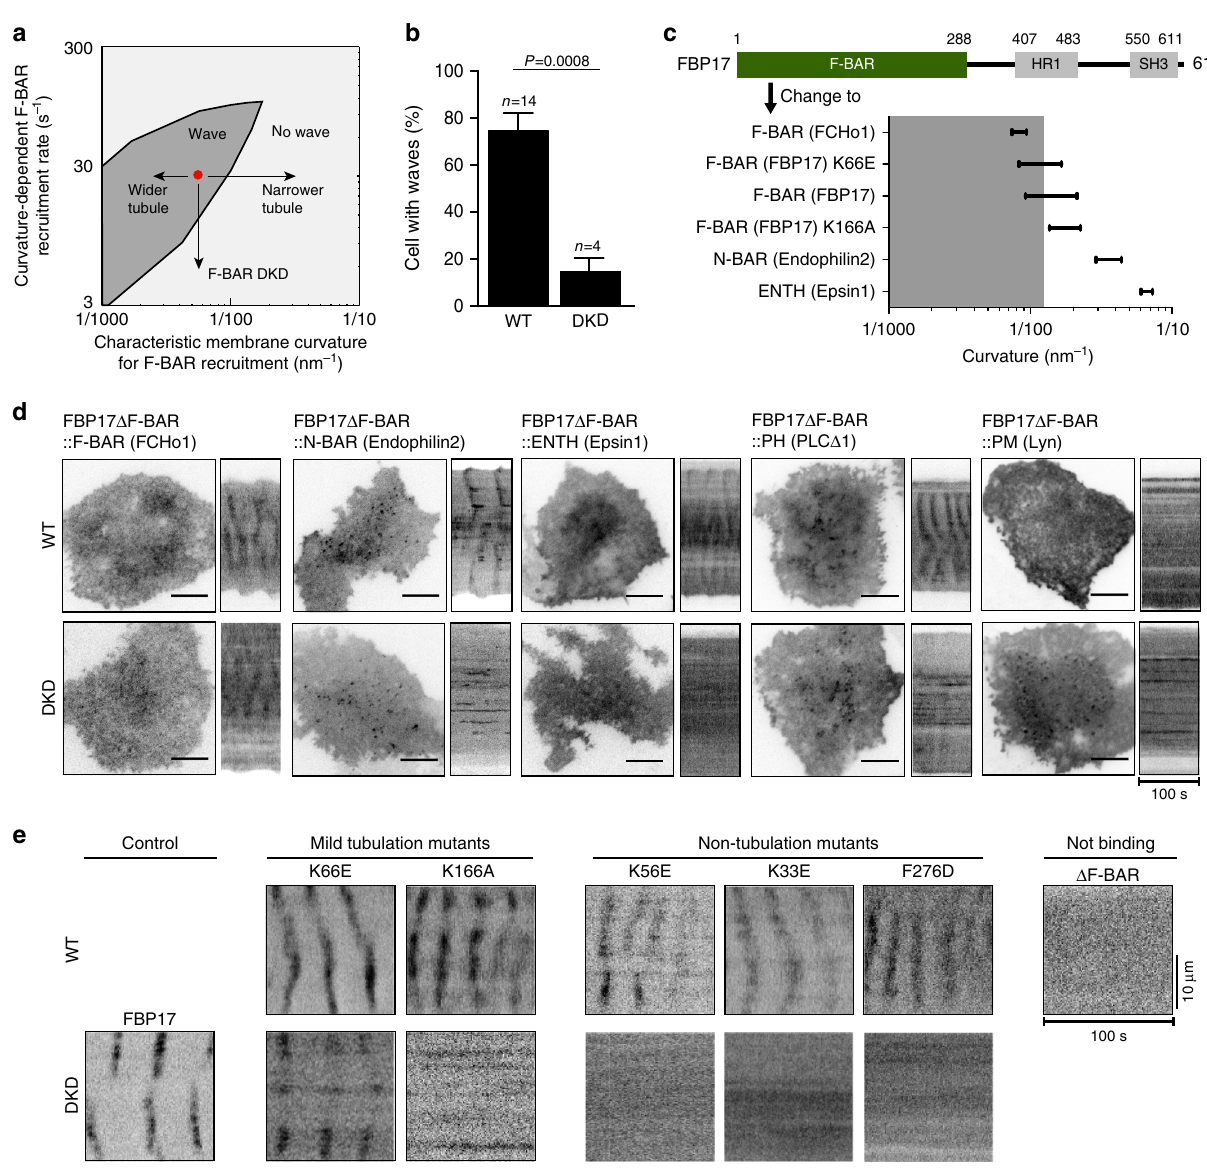
Fig. 3 Wave propagation requires F-BAR and its curvature sensitivity. a Model phase diagram showing the dependence of traveling waves on a proper balance between the curvature-dependent F-BAR-recruitment rate and the characteristic membrane curvature that recruits F-BAR. The red dot represents the model parameter set that generated the nominal model results in Figs. 1 and 2. b Double knockdown (DKD) of FBP17 and CIP4 by shRNA causes a reduction ( P = 0.0008, Student ’ s t -test) in the percentage of cells with active Cdc42 (CBD-GFP) waves (4 experiments with 39 cells in total), comparing to wild-type (WT) cells (14 experiments with 133 cells). Error bars: s.e.m. c F-BAR domain of FBP17 is replaced with other membrane-binding motifs. Ranges of curvature (radius − 1 ) preferences of different membrane-binding domains are plotted 24, 25, 44, 45 . Gray area indicates the curvature range that allows wave formation, corresponding to the gray area of a . d The curvature of F-BAR domain is critical for wave formation. A micrograph and a kymograph for each mutant protein both in WT and DKD conditions are shown. Only the mutant protein with an F-BAR (FCHo1) domain could rescue wave formation in DKD cells. e The ability of point mutants of F-BAR domain of FBP17 to localize to the waves in WT cells or rescue wave formation in DKD cells correlates with their tubulation activities in vitro. Representative kymographs of cells expressing point mutants or full-length construct of FBP17-GFP in WT cells and DKD cells are shown. Mutants are separated into four groups based on curvature-generating abilities. Scale bar: 10 μ